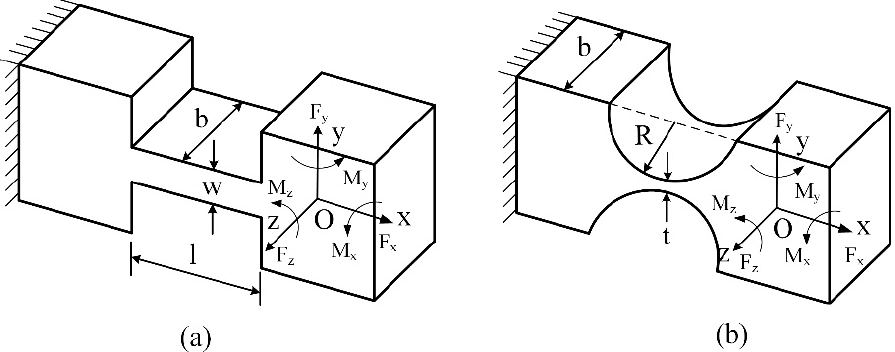
Figure 5. The coordinate system of ( a ) leaf spring flexible hinges and ( b ) right circular flexible hinges.